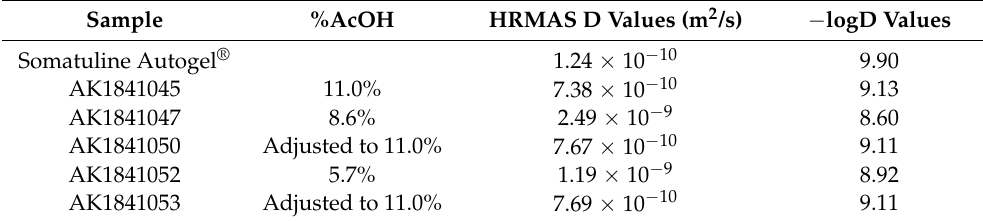
Table 1. Diffusion (D) values (m 2 /s) and the respective − logD transformation calculated from HR-MAS DOSY spectra on each sample.